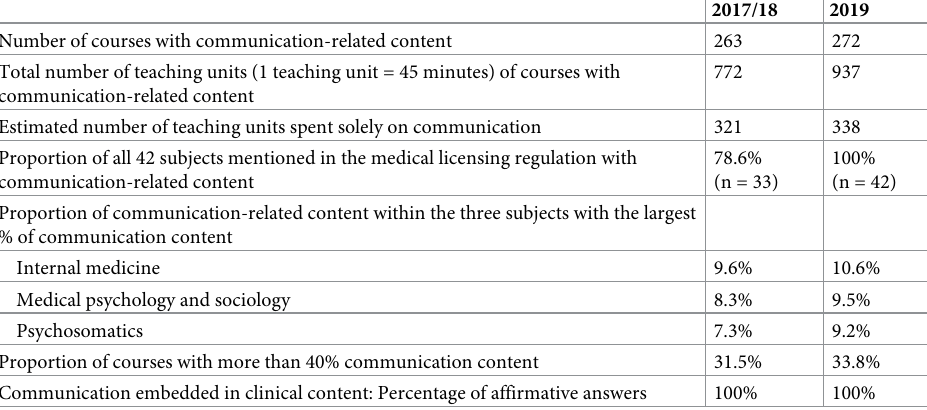
Table 1. Comparison of the integration of communication content in the curriculum between 2017/18 and 2019. Number of courses with communication-related content 263 272 Estimated number of teaching units spent solely on communication 321 338